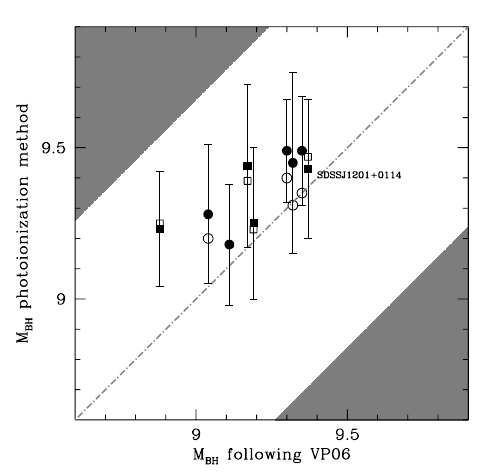
Fig. 3. Comparison of black hole masses computed using the method presented in this paper with those from Vestergaard & Pe- terson (2006). Results are for a pilot sample of quasars at z (cid:25) 3. Filled symbols indicate values from ‘uncorrected’ diagnostic line ratios, open symbols from ‘corrected’ ones. Squares are Pop. A sources; circles Pop. B. The unshaded area sets the error band of Vestergaard & Peter- son (2006) around the line of equal- ity at a 2 (cid:27) con(cid:12)dence